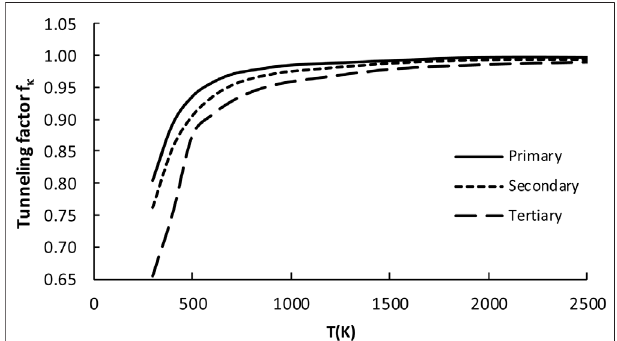
FIGURE 6 | Plot of the tunneling factor ( f κ ) as a function of temperature for all 23 reactions considered in the representative set (R 2 – R 24